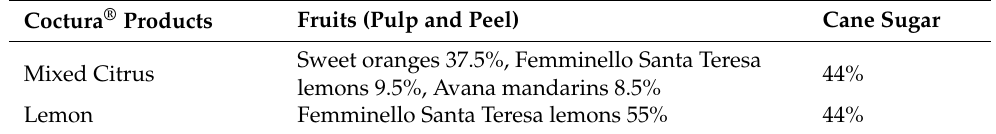
Table 1. Composition (%) of Coctura ® Citrus products.